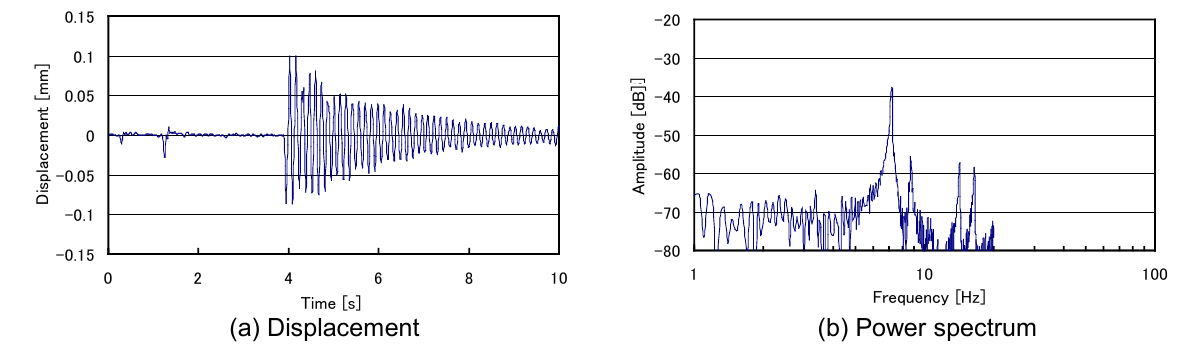
Figure 14. Impulse response for the rotor at the center position of the rotor in the case of a fixed stator, representing ( a ) displacement and ( b ) the power spectrum.